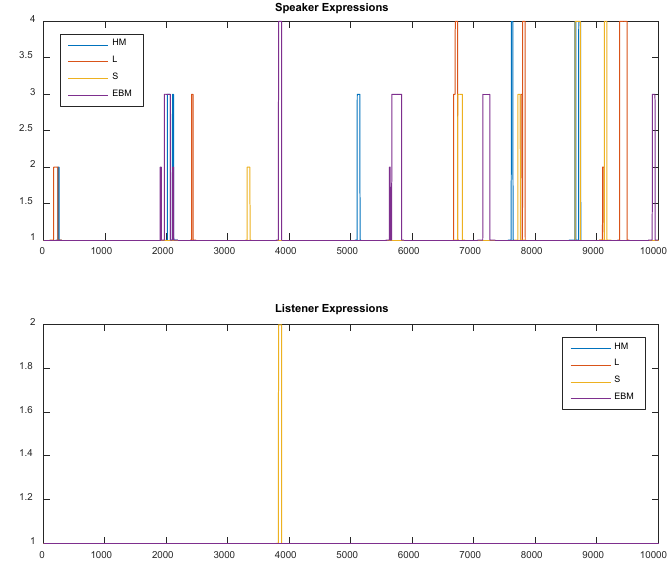
Figure 6 | Sample of predicted expressions using Naive Bayes Classification. Each value of an expression represents one of the possible values that expression can